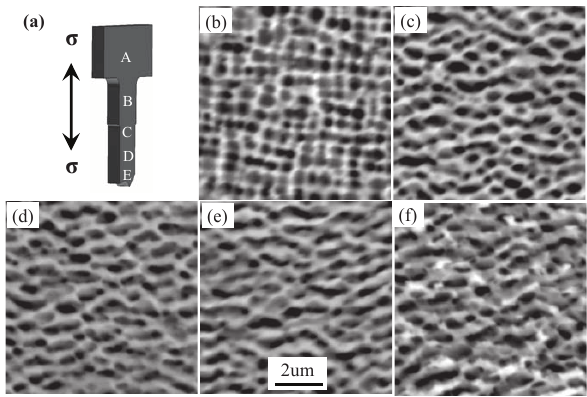
Figure 6. Microstructures in the different regions after the alloy 2 crept up to fracture at 1313 K = 137 MPa. Schematic diagram of marking locations in the specimen, (b), (c), (d), (e) and (f) being SEM morphologies corresponding to the regions A, B, C, D and E,